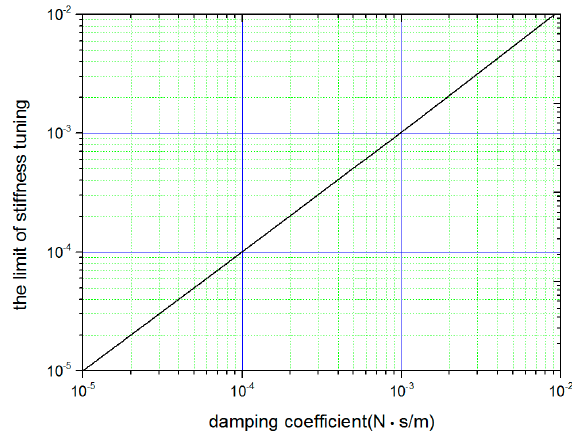
Figure 3. Relationship of the damping coefficient and the limit of stiffness balance. The amplitude of the response function at differential-mode frequency was 2 × 10 − 5 (m/m/s 2 ), and the measurement resolution was set as 1 × 10 − 6 (m/m/s 2 ) artificially. For each damping coefficient, the depth of the valley around f ci of the response function was calculated at different mismatches of stiffness to find the limit of stiffness balance.